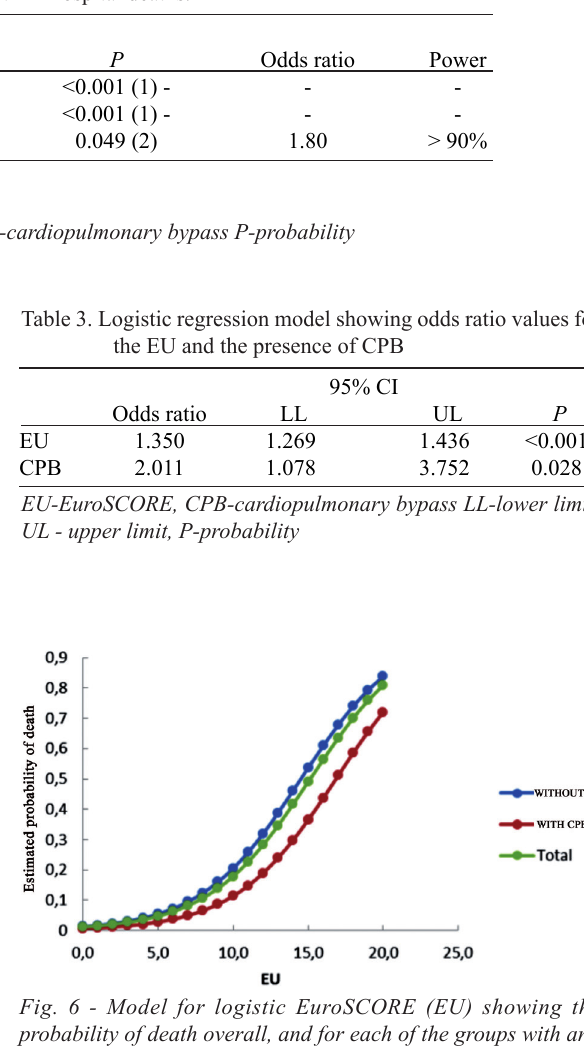
Table 1. Association of CPB and the value of the score with in-hospital deaths.